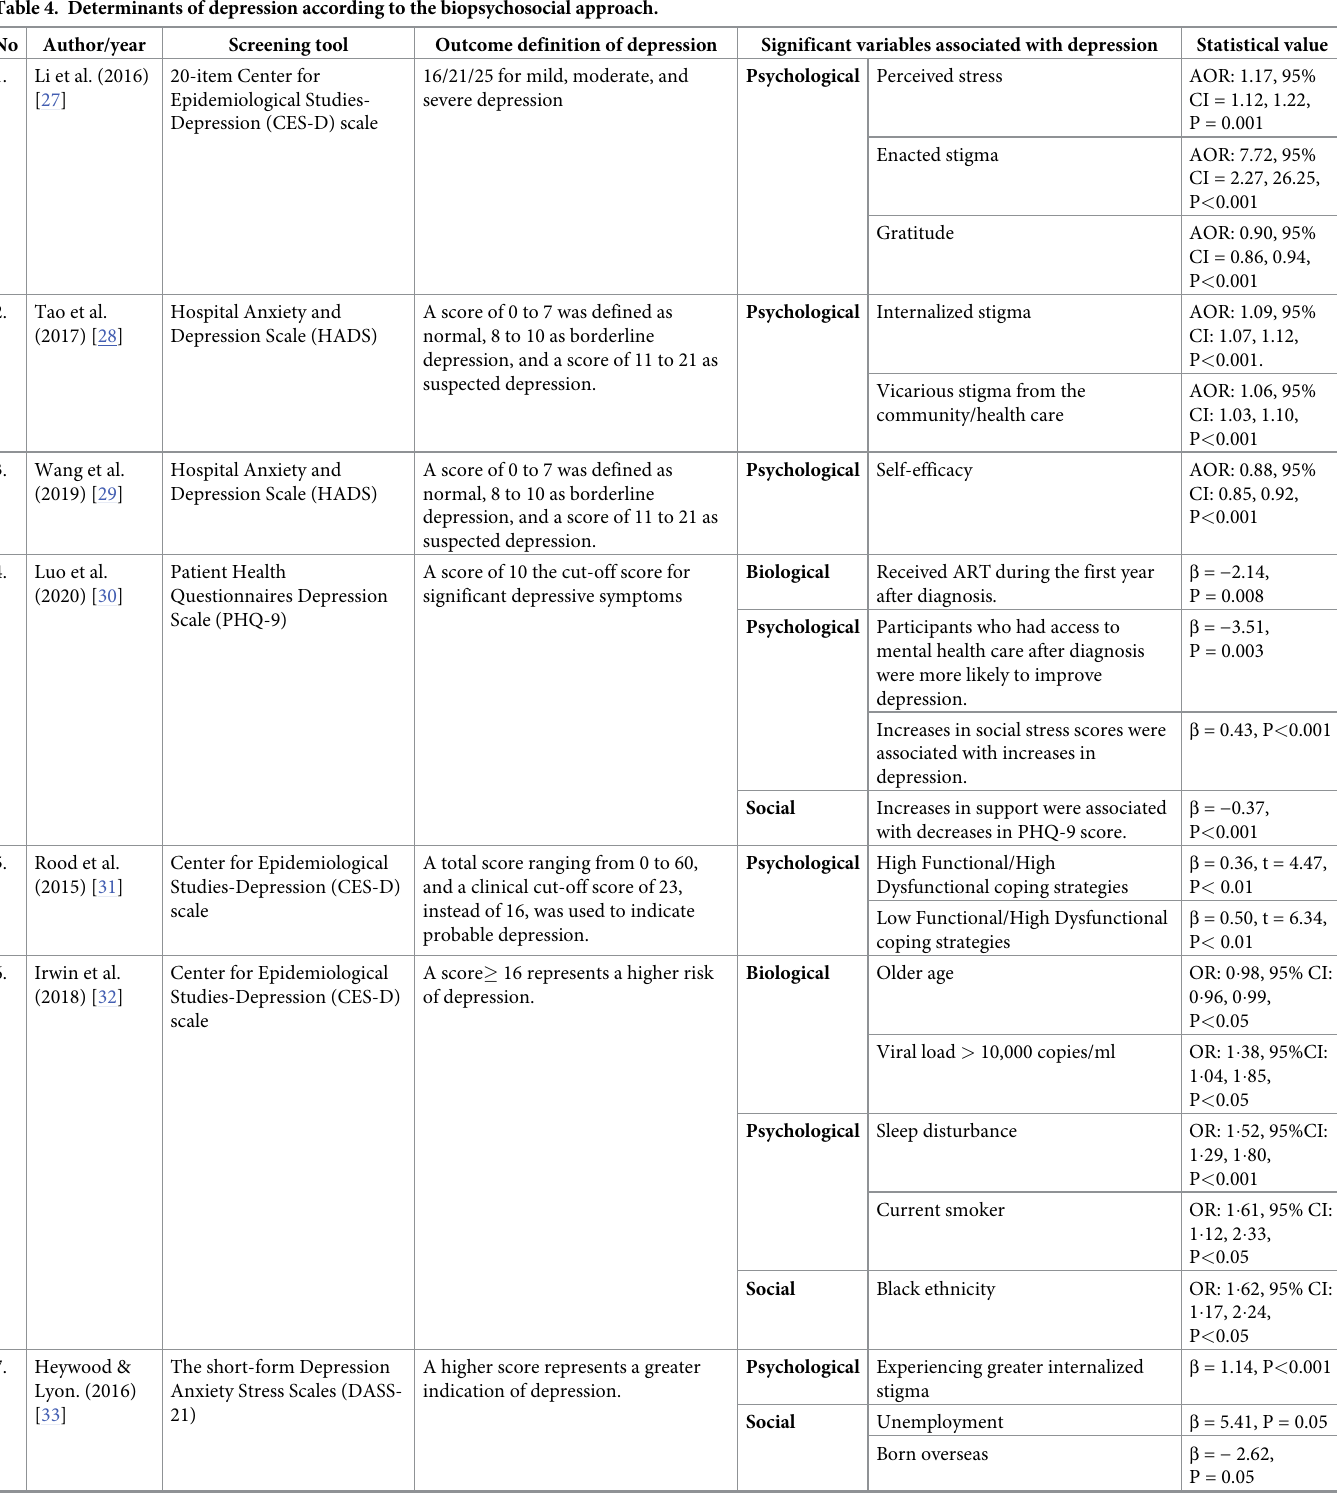
Table 4. Determinants of depression according to the biopsychosocial